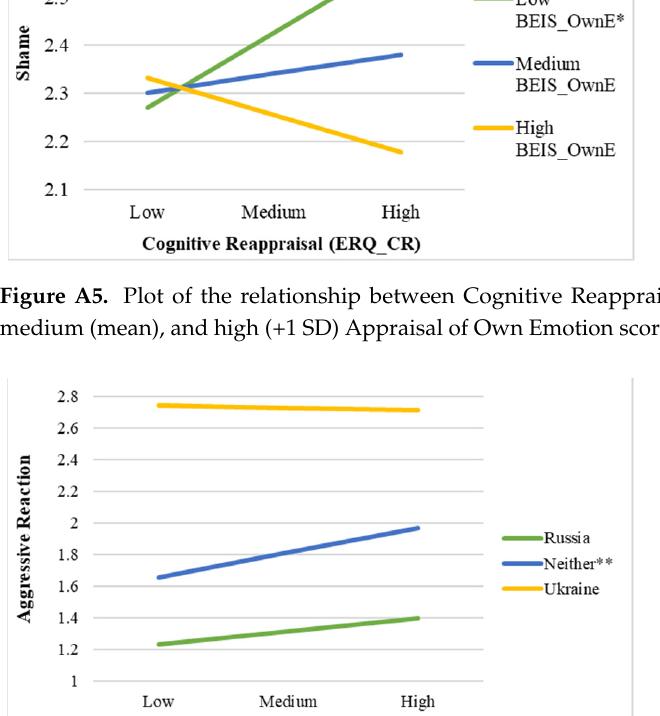
Figure A6. Plot of the relationship between Shame and Aggressive Reaction on Russia, Ukraine, and Neither Political Alignment; ** = p < 0.01.